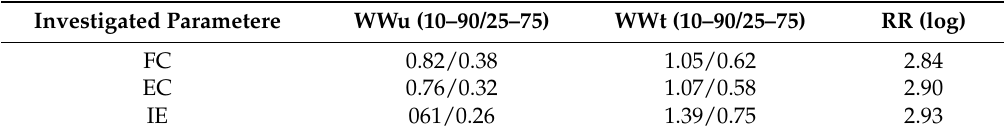
Table 2. Range (Logarithmic steps) between 10% and 90% Perzentile and Quartiles (25% and 75%) for fecal coliforms (FC), Escherichia coli (EC) and intestinal enterococci (IE) in the waste water untreated and waste water treated WWu and WWt, and linear and logarithmic reduction rates (RR) (MPN/100 mL).